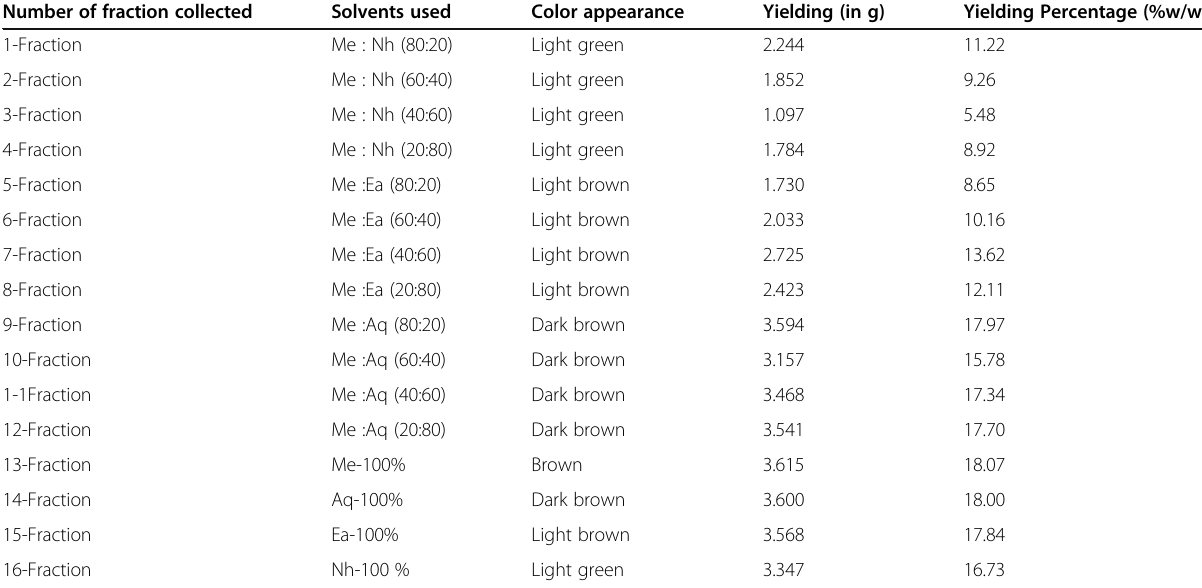
Table 2 MeCV isolated fractions extractive values Number of fraction collected Solvents used